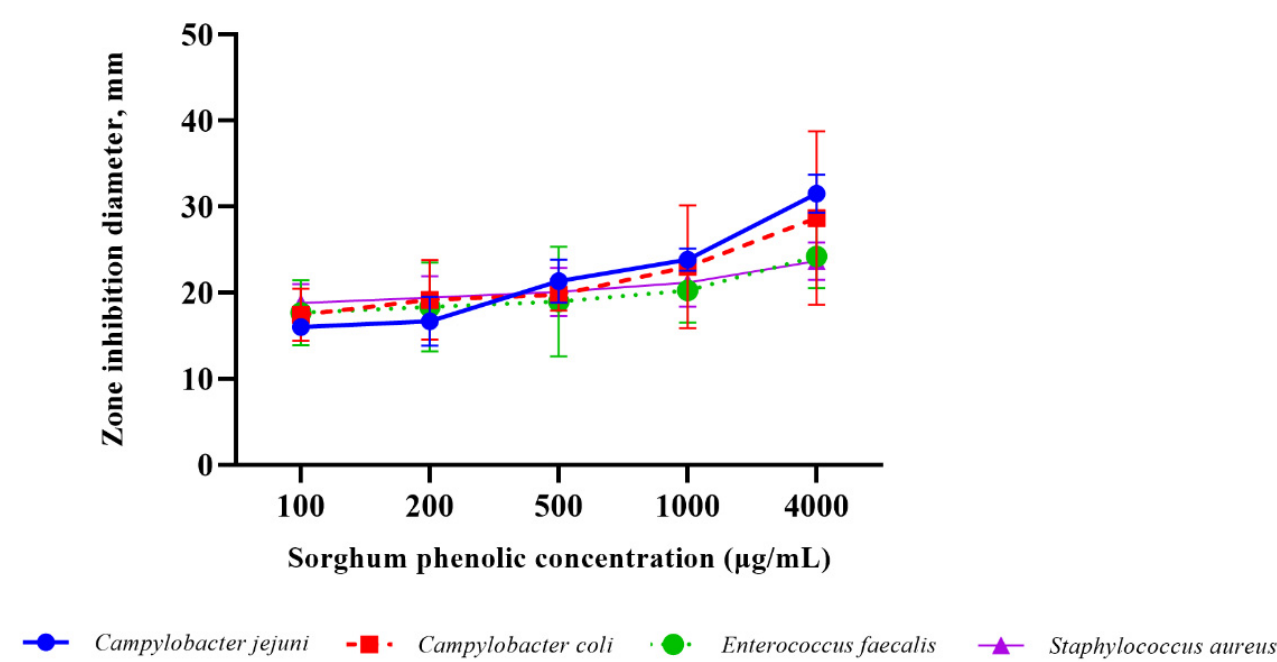
Figure 1. Antibacterial effects of sorghum phenolic extract concentrations for Campylobacter jejuni , Campylobacter coli , Enterococcus faecalis , and Staphylococcus aureus . Each line represents an average value (of three separate runs) with 95% CI.